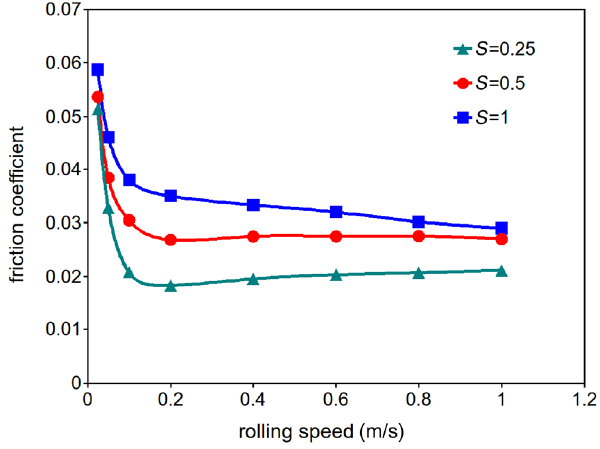
Fig. 12 Trends of friction coefficient as function of rolling speed for three values of slide-to-roll ratio S .